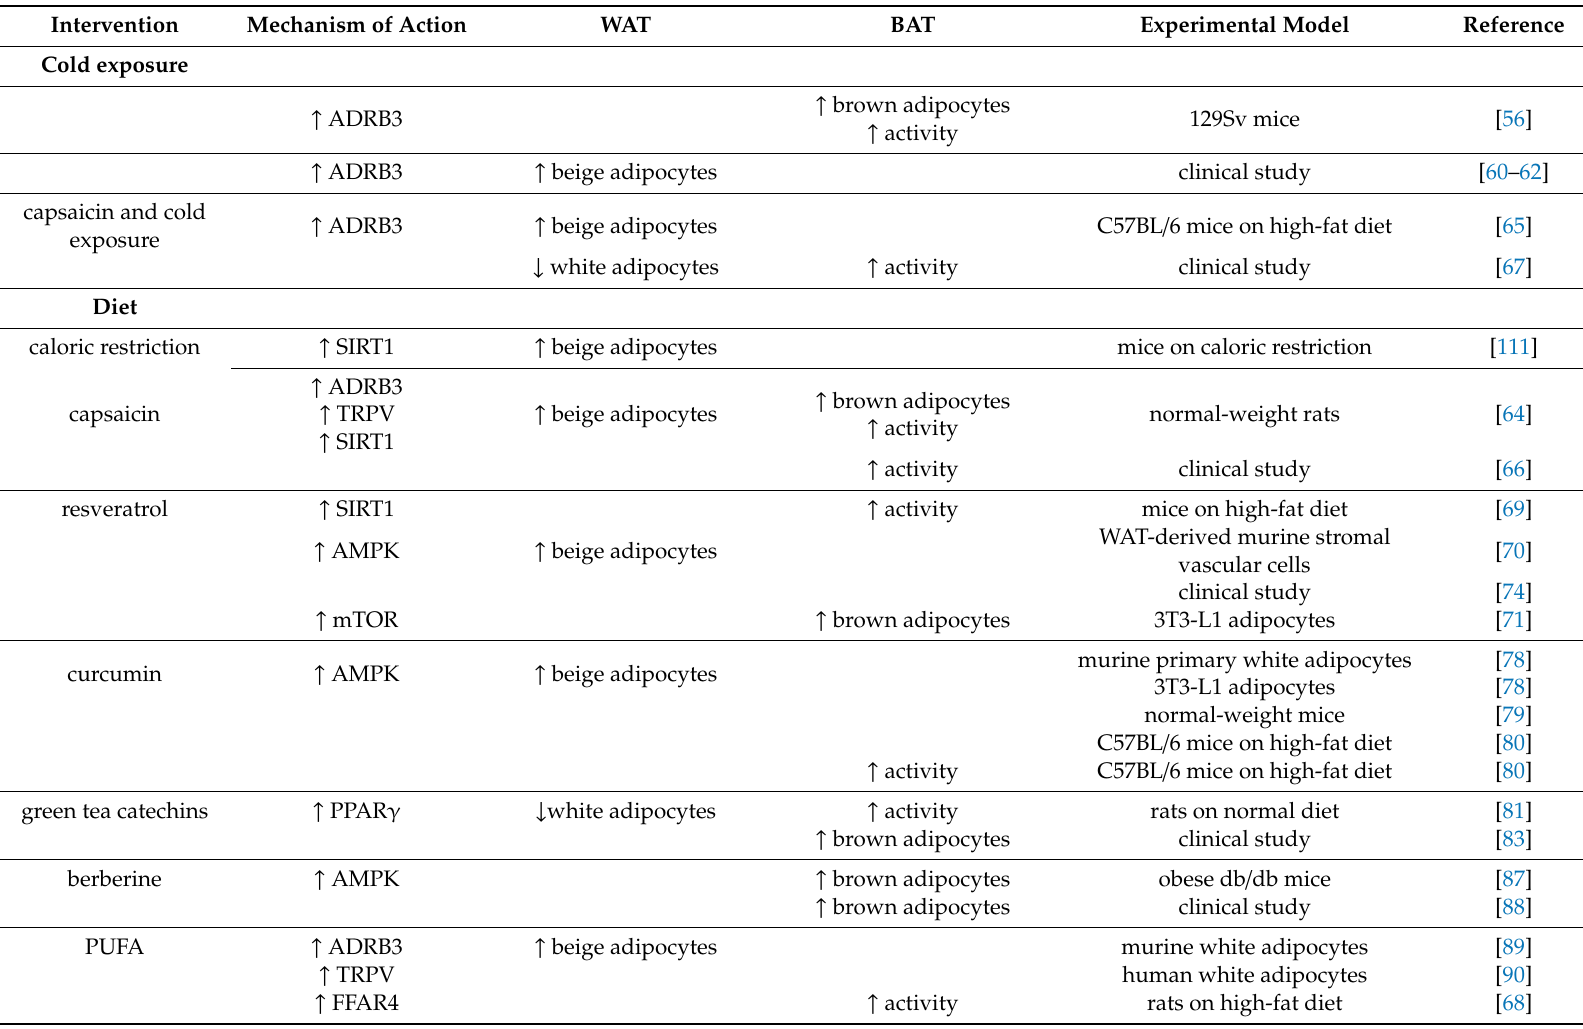
Table 1. Selected non-pharmacological interventions aiming at white adipose tissue (WAT) browning and brown adipose tissue (BAT) activation.